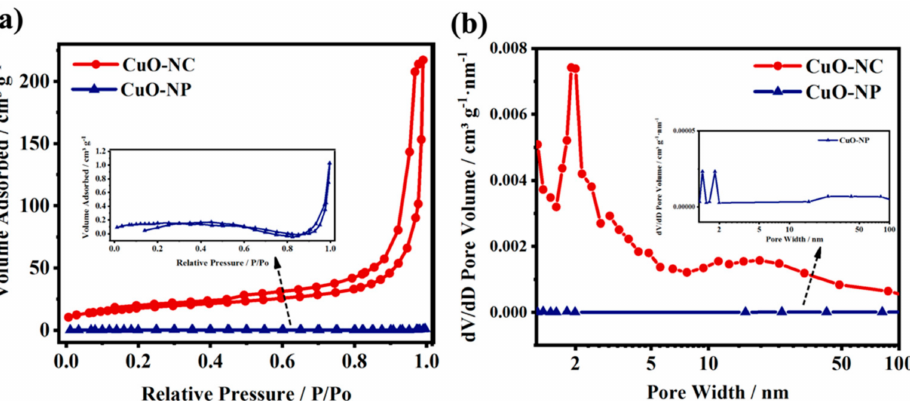
Figure 2. Porosity analysis of nano − CuOs. ( a ) N 2 isotherms of adsorption-desorption curves at 77 K and their corresponding and ( b ) pore size distributions. The inset of ( a , b ) is the correspondingly enlarged view of CuO −